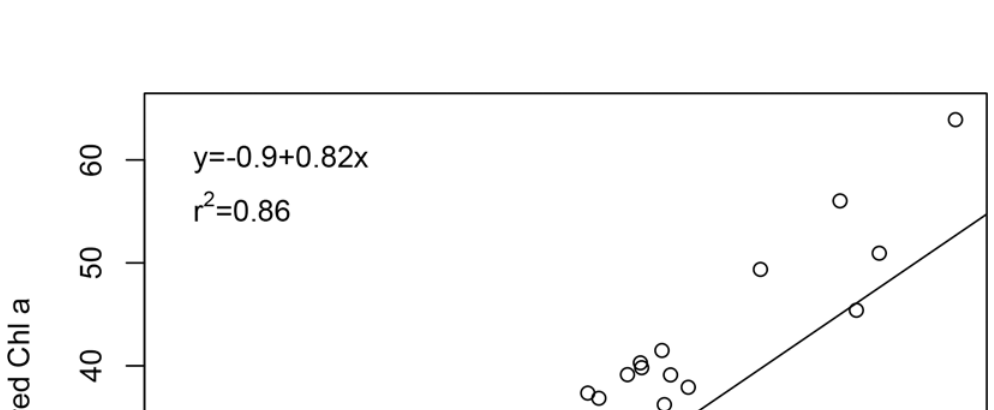
Fig 4. Scatterplot of HPLC measured Chl a and spectrophotometrically measured Chl a in Lake V õ rtsjärv (2009 – 2013).